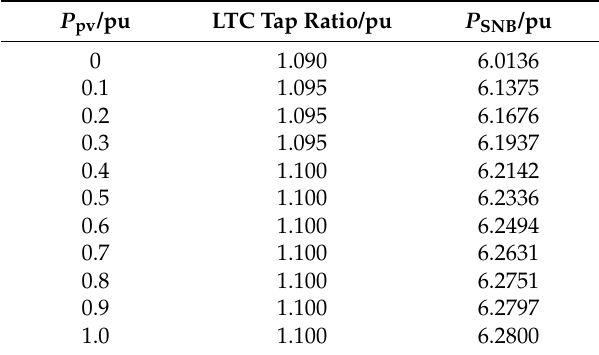
Table 5. The values of the load’s active power at the SNB points of the IEEE 14-bus system with PVs including a load tap changing transformer (LTC)